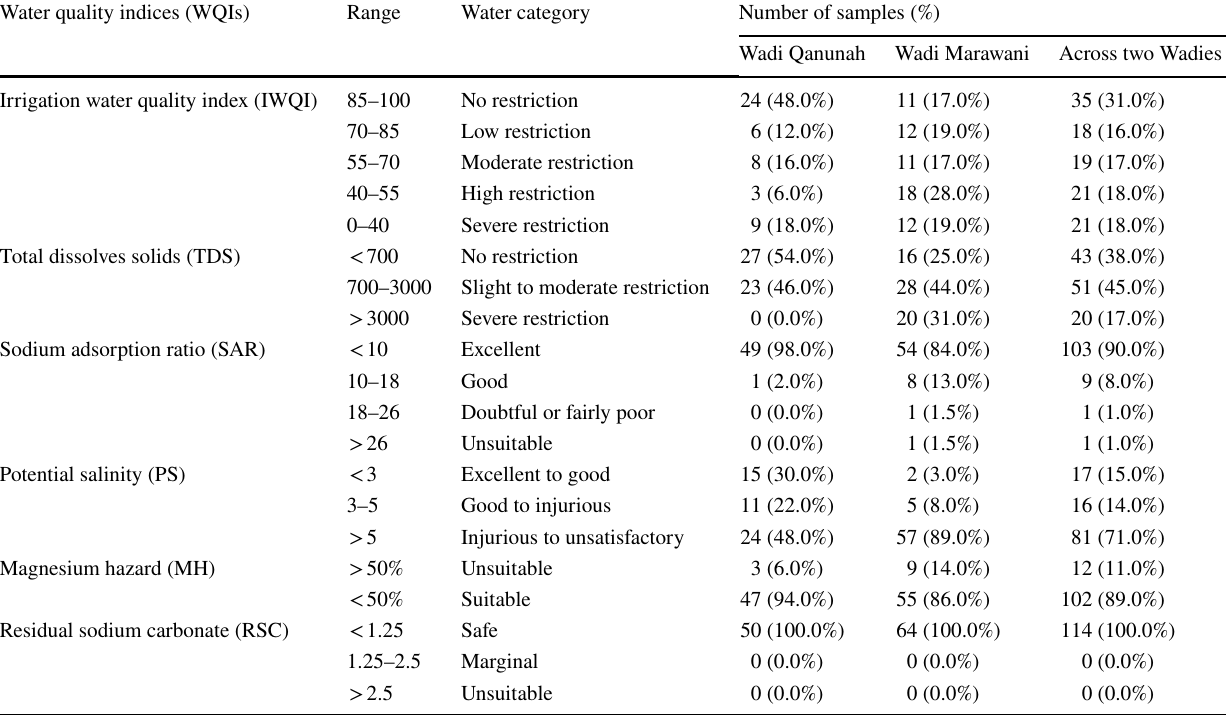
Table 5 Classification of the different water quality indices (WQIs) Water quality indices (WQIs) Range Water